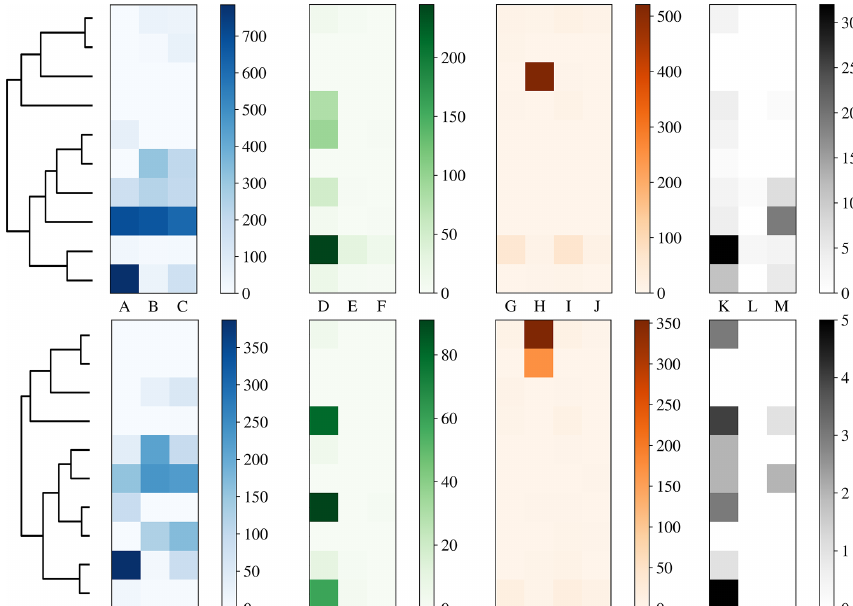
Figure 12. Dendrogram truncated at 10 clusters (left) for laboratory data collected in 2014 alongside a heat map of matching matrix (right) indicating cluster composition by each sample segregated by bacteria, fungal, pollen and non-biological in blue, green orange and black, respectively. Separate scales are used for each broad class to prevent the dominant class obscuring detail in the other classes. Hierarchies for 3 σ (top) and 9 σ (bottom) are